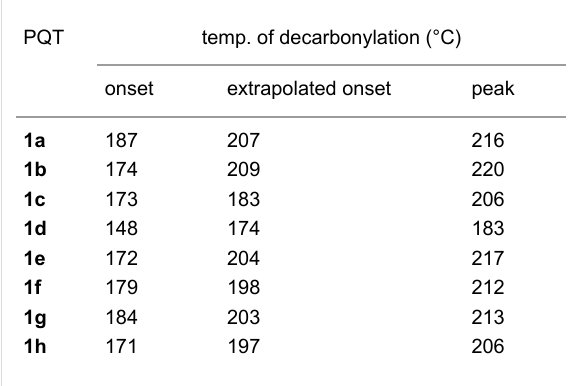
Table 1: Thermal characteristics of decarbonylation of PQTs 1a – h